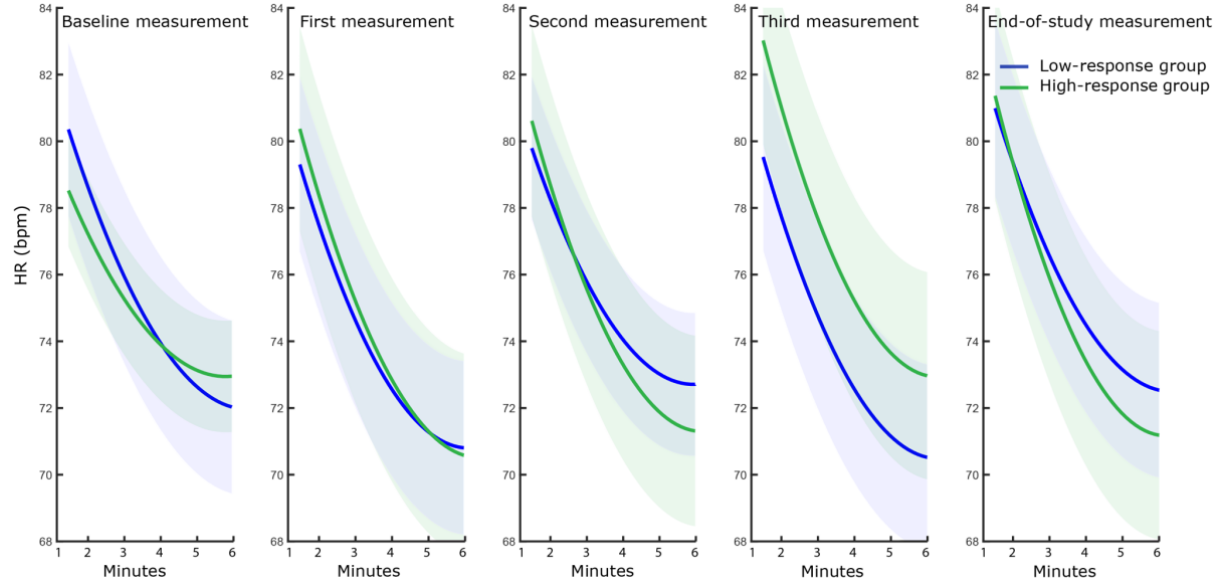
Figure 6. Mean quadratic polynomial fit to the changes in heart rate (HR) during all sessions while recuperating. The line represents the mean fit and the shadows represent the SD. bpm: beats per